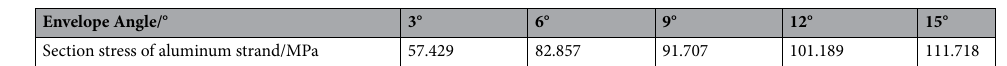
Table 12. Stress simulation results of aluminum strand under tension load of